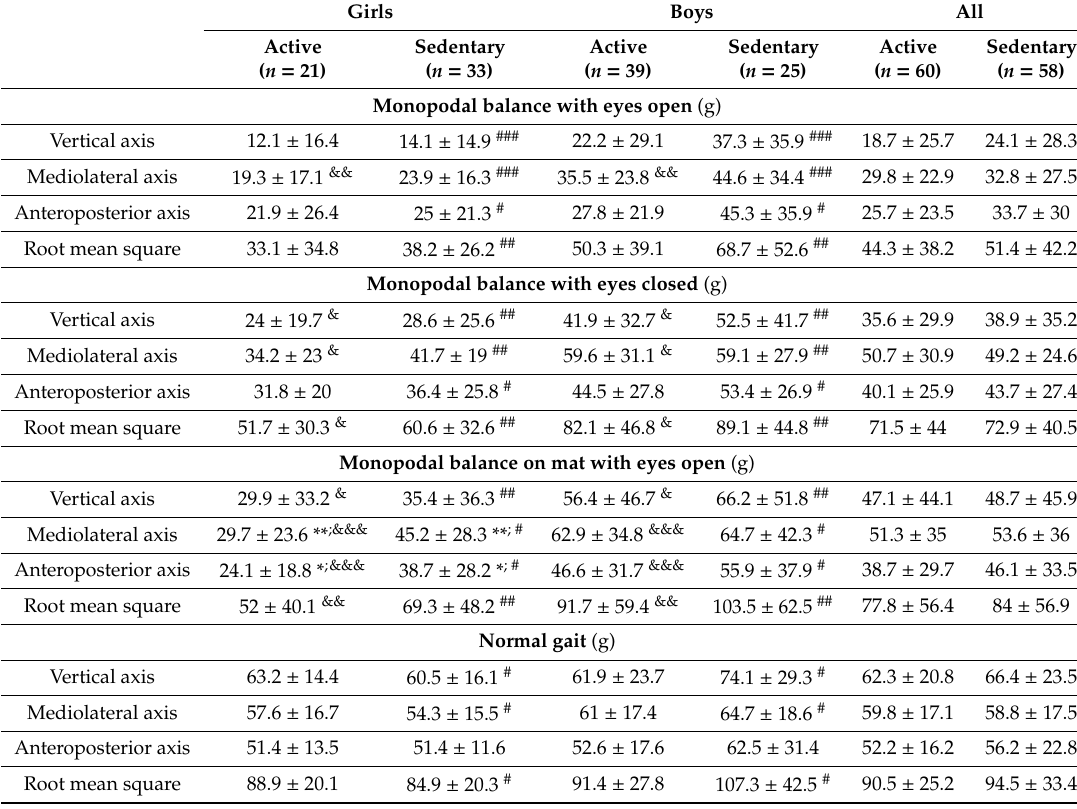
Table 3. Comparative analysis between active and sedentary children (mean ± standard